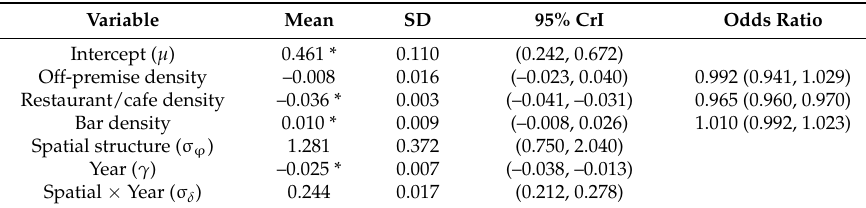
Table 6. Spatial-temporal Bayesian model estimates of alcohol-related calls-for-service controlled for neighborhood-level covariates.